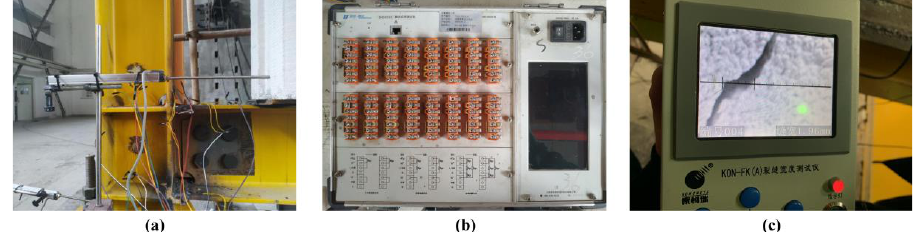
Figure 11. Equipment used for the test: ( a ) Displacement meter; ( b ) data collector; ( c ) crack observer.